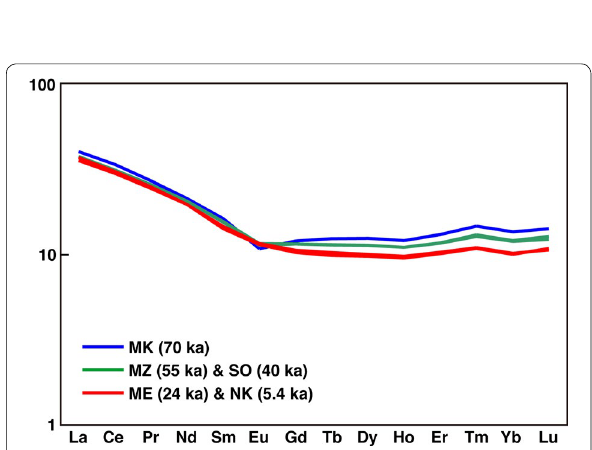
Fig. 7 Condrite-normalized REE patterns for the products of Numazawa Volcano. Abbreviations are same in Fig. 5. The normalizing values are from McDonough and Sun (1995). Middle and heavy REE in the products depleted with time. Data are from Yamamoto (2007)